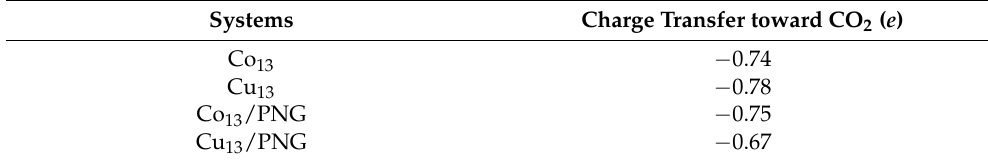
Table 2. Charge transfer from Co 13 , Cu 13 , Co 13 /PNG, and Cu 13 /PNG to CO 2 molecule. The negative values indicate charge transfers from the nanoclusters and nanoclusters/PNG to the CO 2 molecule.